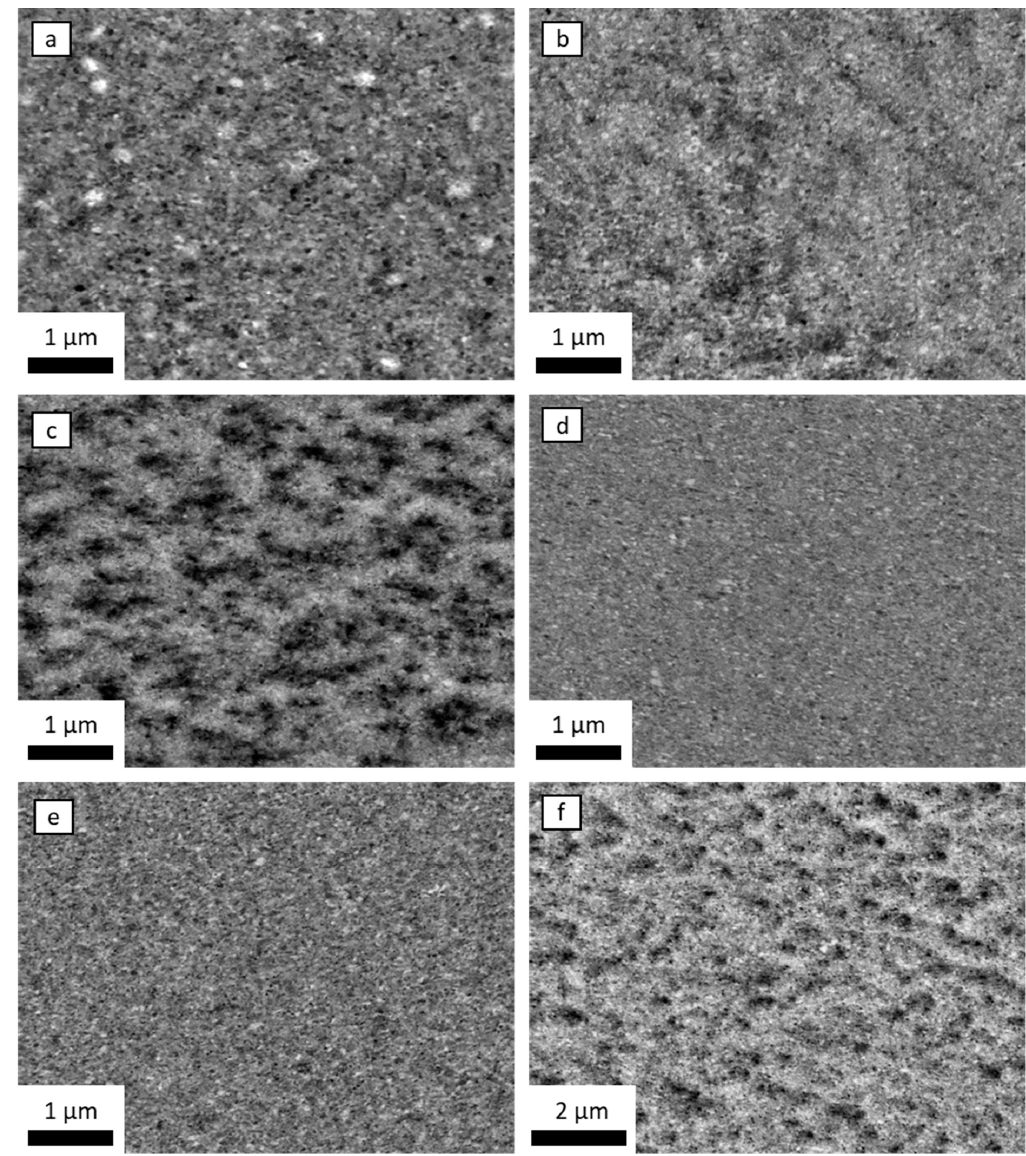
Figure 3. SEM micrographs of HPT-deformed samples, taken at r = 3 mm (with the exception of ( c )) in tangential direction. ( a ) Cu 81 Co 19 ; ( b ) Cu 64 Co 36 ; ( c ) Cu 55 Co 45 (r = 10 mm, large HPT-tool, deformed at elevated temperature); ( d ) Cu 52 Co 48 ; ( e ) Cu 49 Co 51 deformed at 200 °C; ( f ) Cu 22 Co 78 deformed at 300 °C.